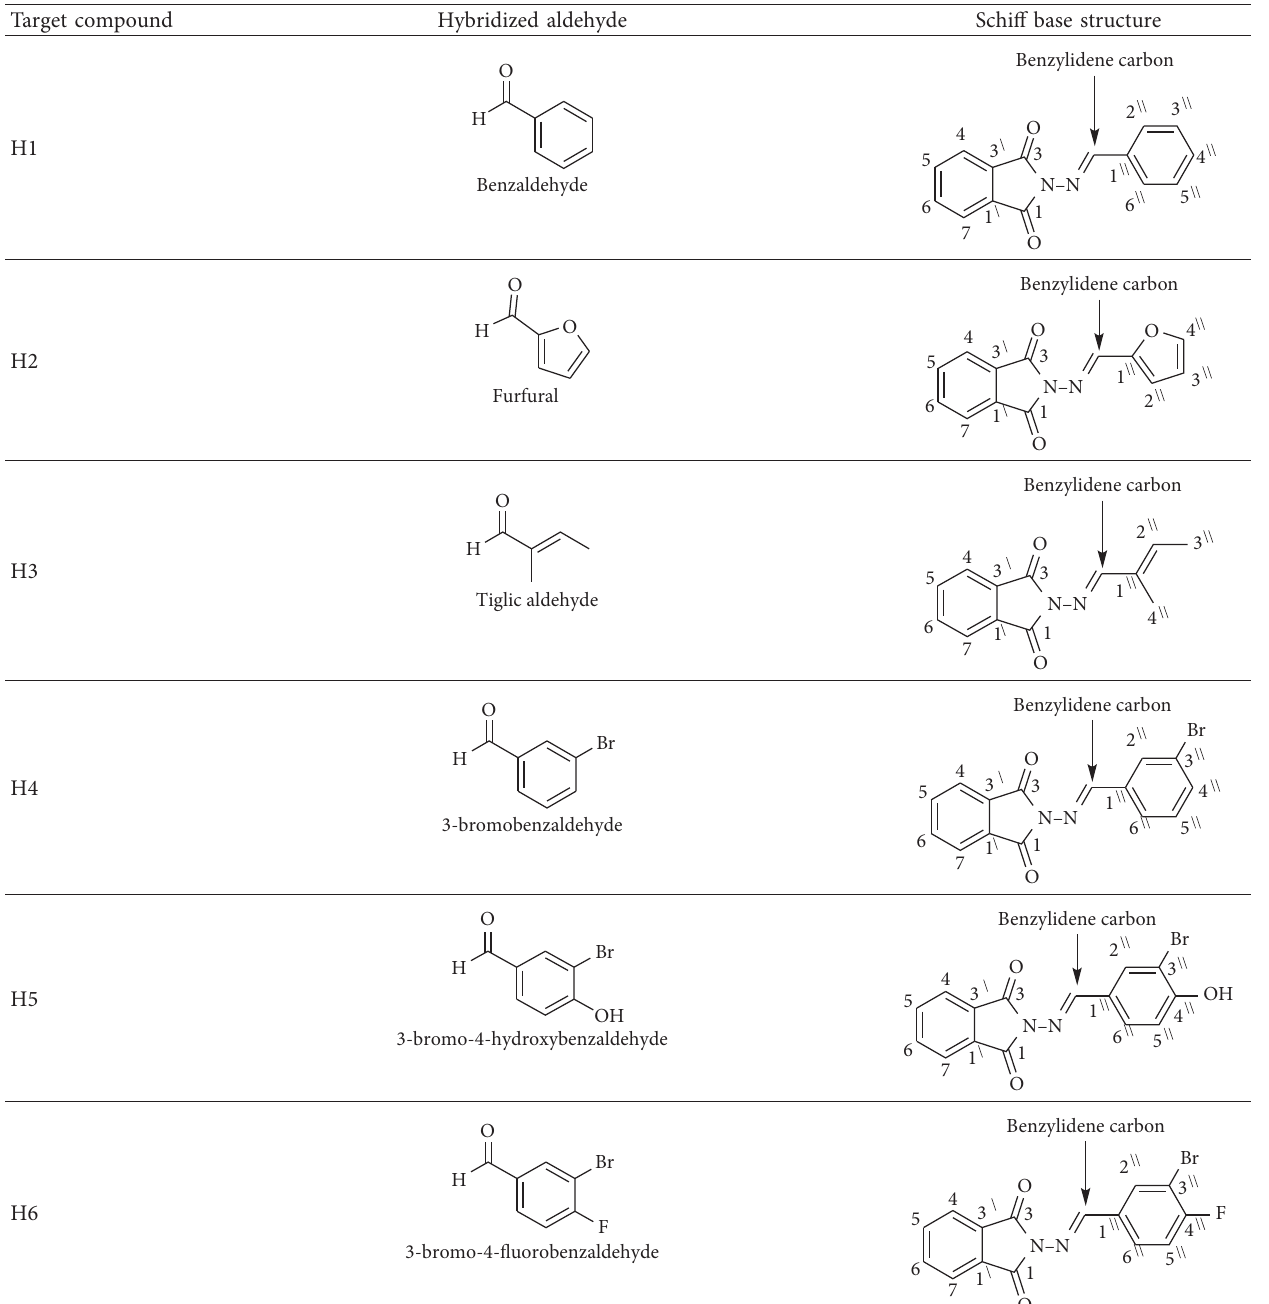
Table 1: Imines design and hybridization